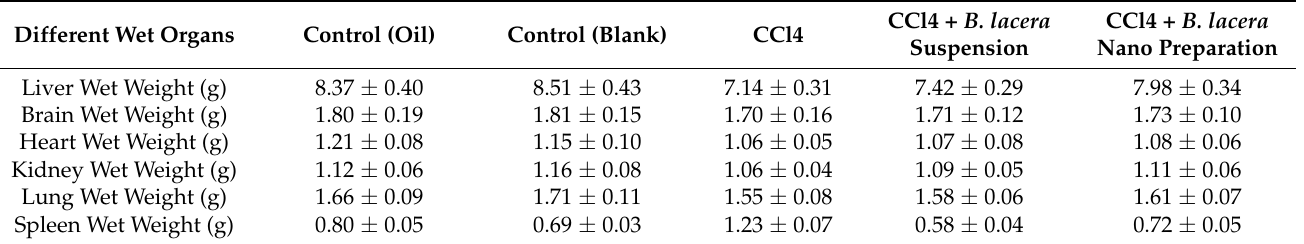
Table 4. Effect of B. lacera leaf extract and its liposomal preparation on different organ wet weights. Data are presented as mean ± standard error of mean, where n = 6.